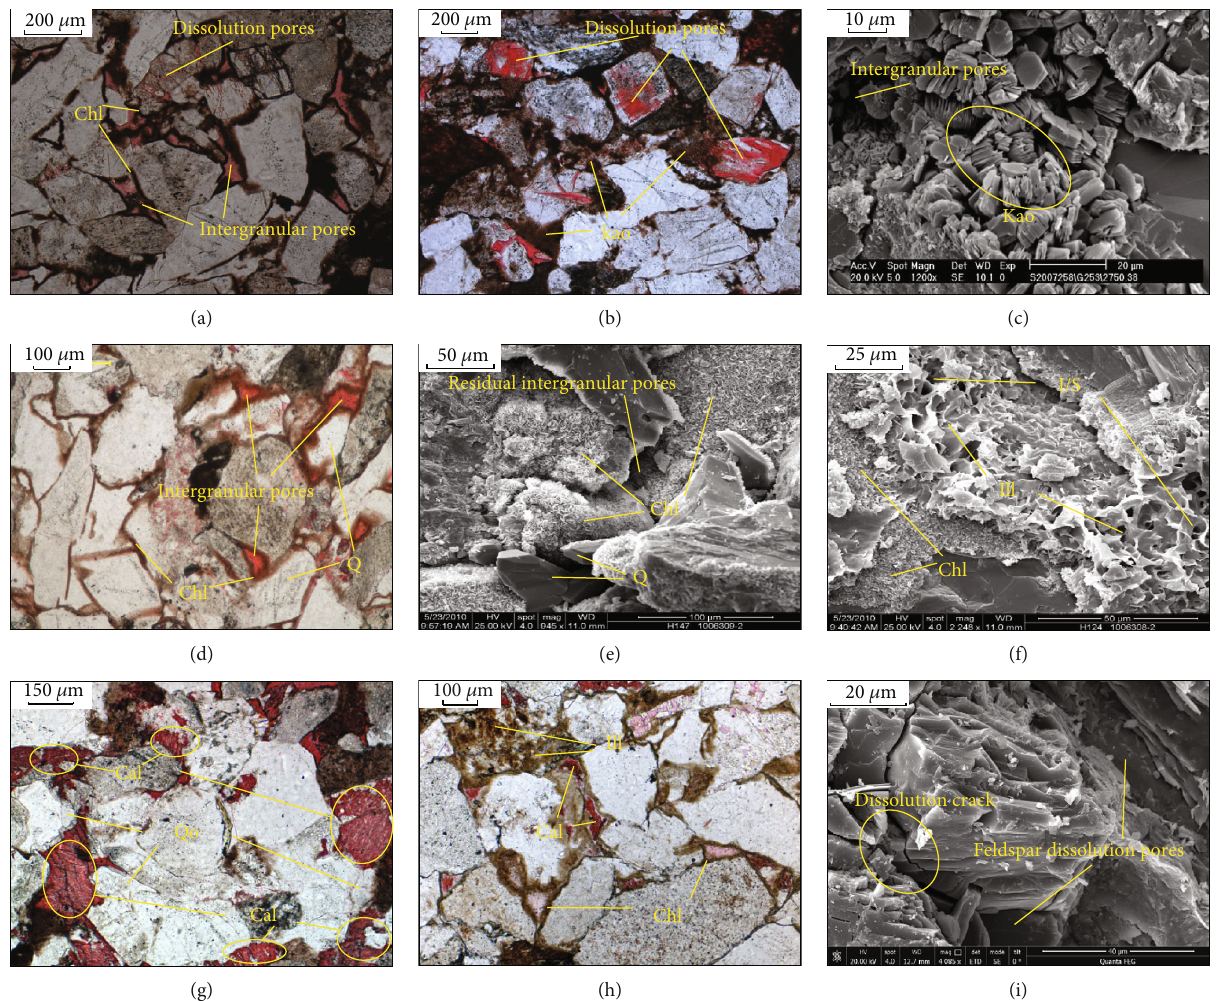
Figure 4: Pore types and fi lling mineral compositional characteristics of the Chang 8 reservoir in the study area. (a) YPA, chlorite fi lm 2 fi lling pores. Chl stands for chlorite. (b) YPA, kaolinite fi lls the pores, and dissolved pores are visible. Kao stands for kaolinite. (c) APA, book-like kaolinite fi lling intergranular pores. (d) YPA, chlorite fi lm, and intergranular pores and siliceous fi lling pores. Q stands for quartz. (e) APA, quartz overgrowths, and chlorite and authigenic quartz are distributed on the grain surface and in the intergranular pores. (f) YPA, illite, and I/S mixed layers are distributed in the dissolution pores, and chlorite is distributed on the grain surface. Ill stands for illite, and I/S stands for illite/smectite mixed layer. (g) APA, quartz overgrowths are common, and calcite fi lls the pores and metasomatizes debris. Qo stands for quartz overgrowth. (h) YPA, chlorite fi lm is developed, and calcite and authigenic illite fi ll the pores. Cal stands for calcite. (i) APA, feldspar dissolution produces dissolution pores and intragranular